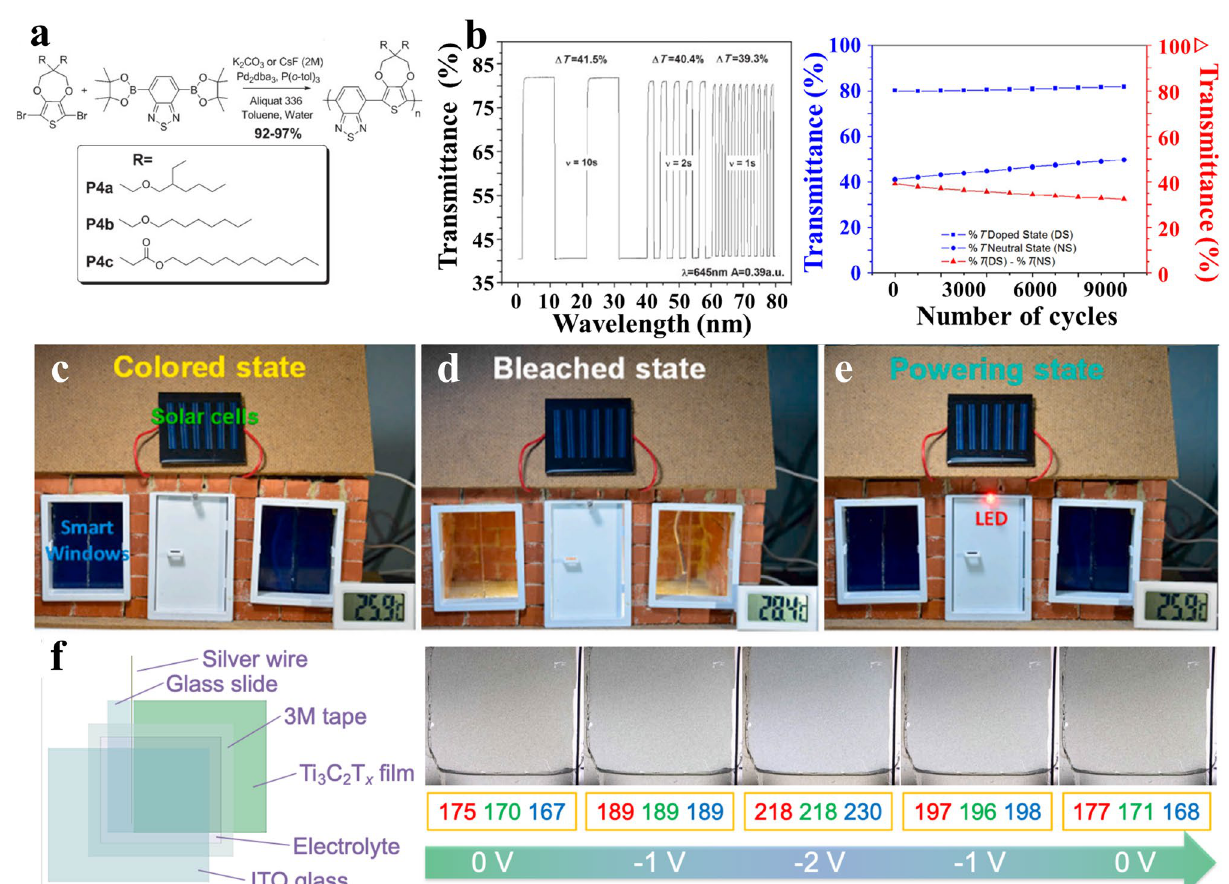
Fig. 5 Progress of conducting polymers and other novel electrode materials in MERABs. a Structures of DA copolymers. b Switching speed and cycling performances. Reproduced with permission [69]. Copyright 2010, Wiley–VCH. c Coloring state, d bleached state and e powering state of the PB-based EES window. Reproduced with permission [73]. Copyright 2020, Elsevier. f Schematic illustration of MXene-based device and corresponding digital photos of the as-fabricated device under different potentials. Reproduced with permission [74]. Copyright 2021,